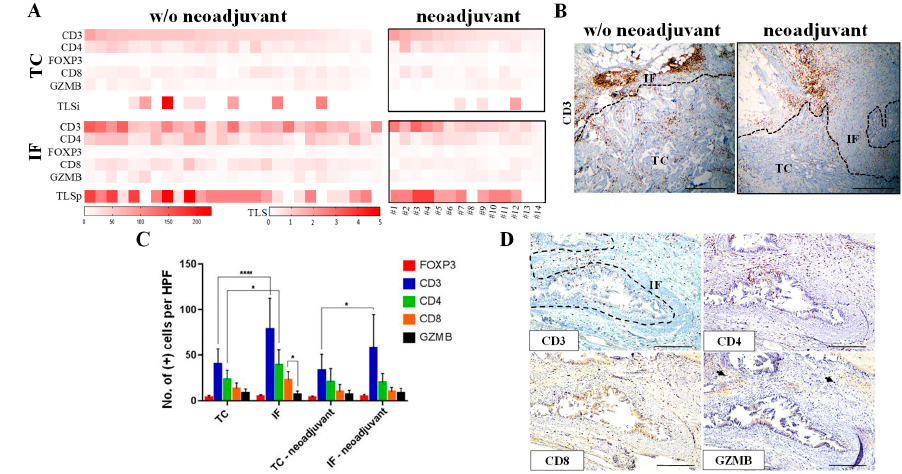
Figure 1. Distinct immune profile in the tumor center (TC) and the invasive front (IF) in pancreatic ductal adenocarcinoma (PDAC) patients. ( A ) Heatmap analysis of the protein expression of